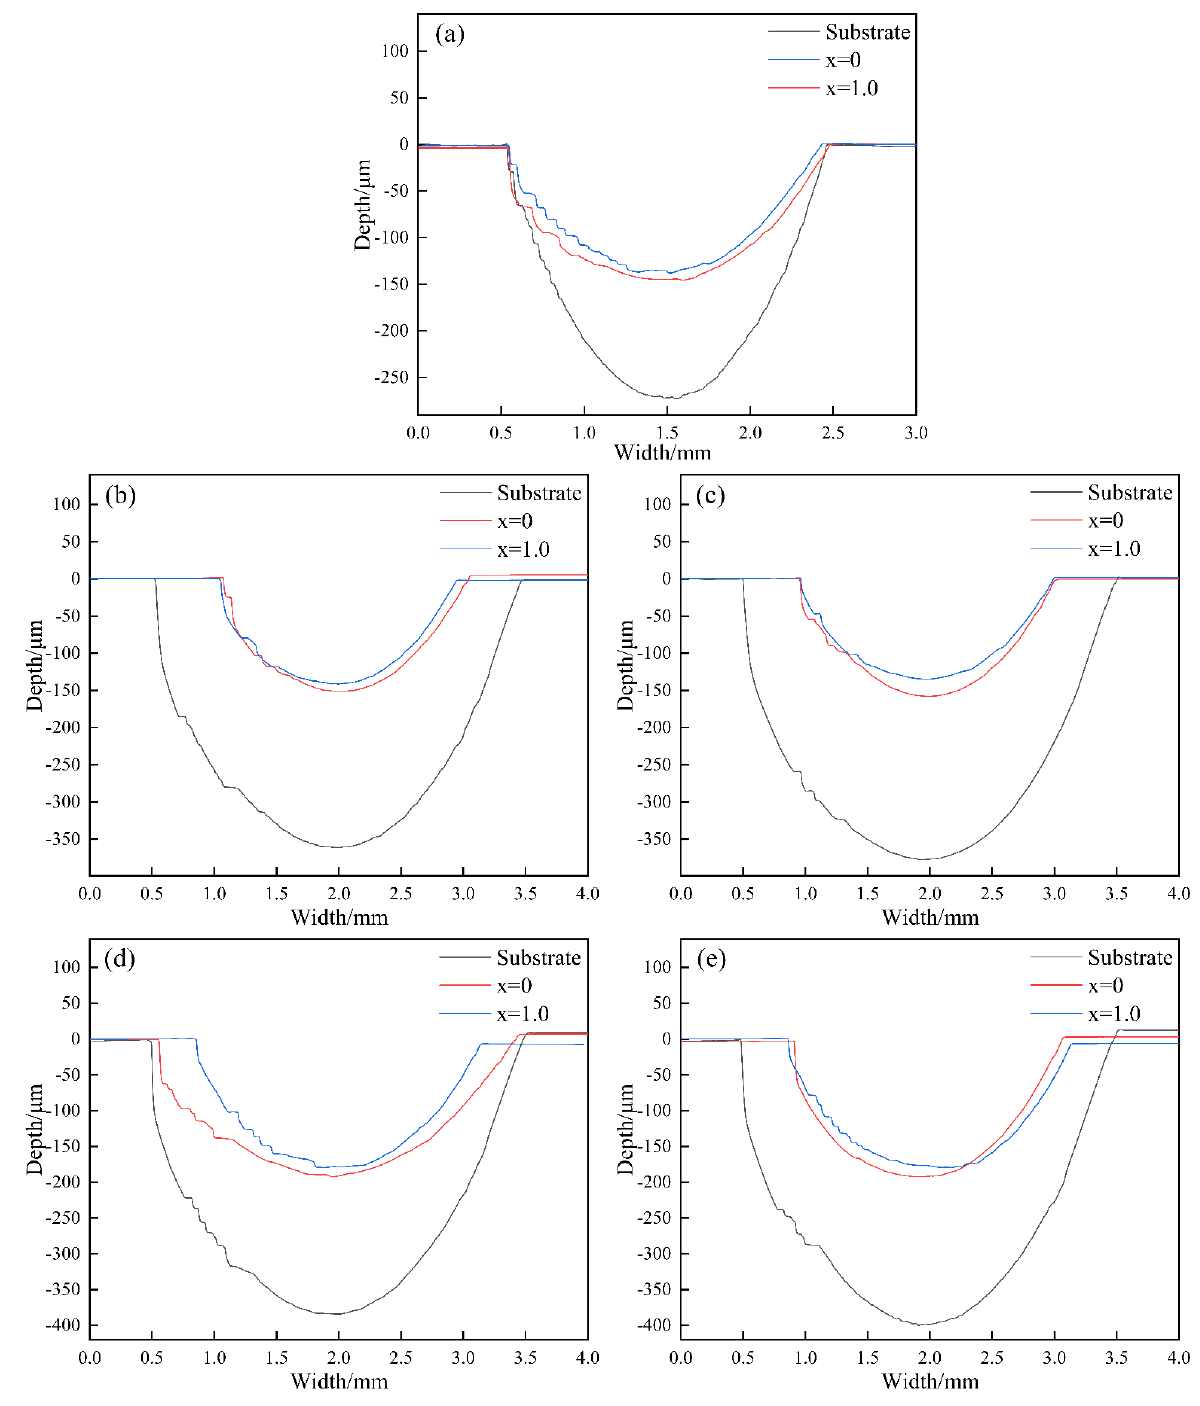
Figure 10. Wear profiles of the samples: ( a ) 2, ( b ) 4, ( c ) 6, ( d ) 8, and ( e ) 10 h. Table 4. Wear rates of the samples at different wear times (mm 3 · N − 1 · m − 1